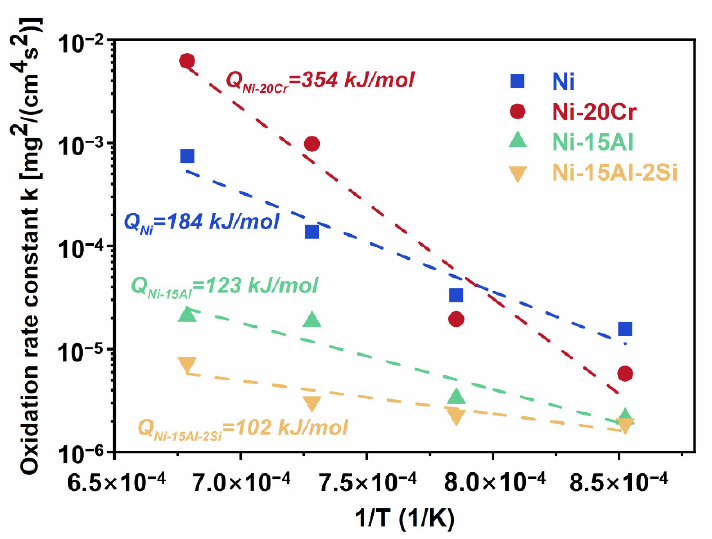
Figure 9. Temperature dependence of oxidation rate constants of Ni, Ni-20Cr, Ni-15Al, and Ni-15Al- 2Si alloys at temperatures ranging from 900 °C to 1200 °C. Slopes of curves represent activation energy Q in Equation (2).